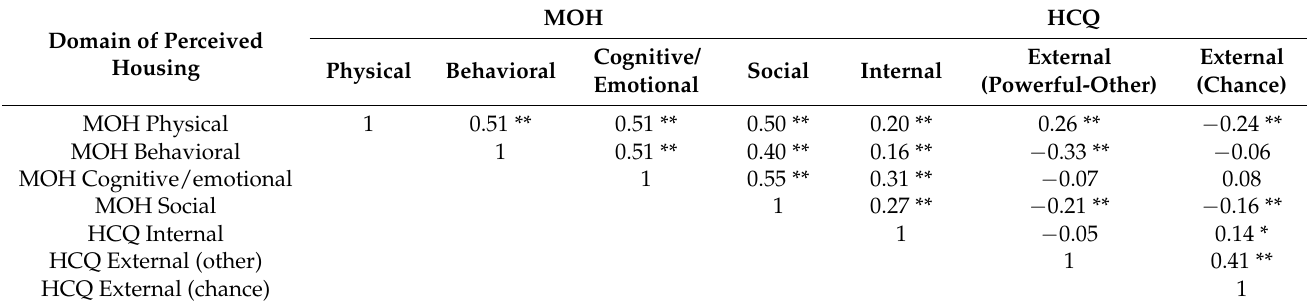
Table 4. Correlations between Meaning of Home and Housing-Related Control Beliefs